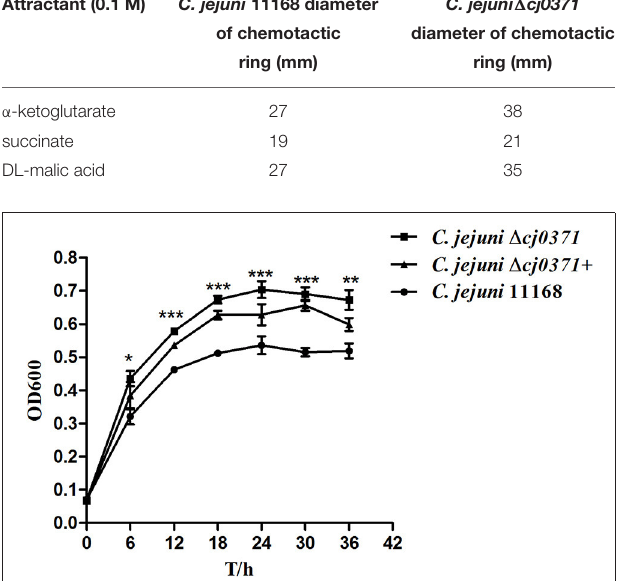
1 cj0371 grows significantly faster than C. jejuni 11168 (6 h, P < 0.05; 12 h, P < 0.001; 18 h, P < 0.001; 24 h, P < 0.001; 30 h, P < 0.001; 36 h, P < 0.01). C. jejuni 1 cj0371 + grows